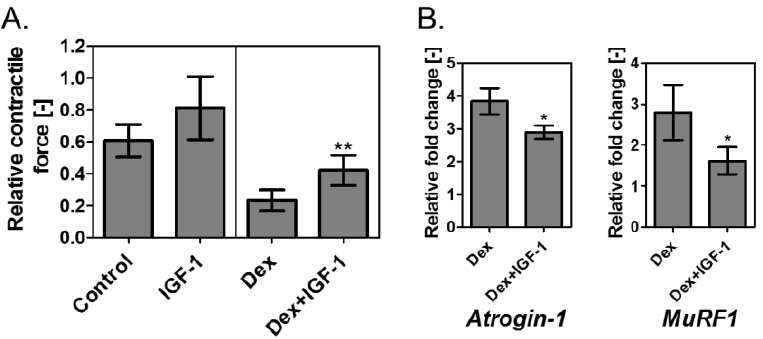
Figure 5. Effects of IGF-I addition on atrophic skeletal muscles. ( A ) Variation in contractile force of atrophic tissues by the addition of Dex. The muscle tissues on the device prepared by six-day differentiation culture (0 h) were treated with 100 µM Dex for 48 h (Dex group). For Dex + IGF-I group, 8 ng/mL IGF-I was added at 24 h and incubated for the subsequent 24 h. Muscle contractile force was measured at 48 h. The relative value was determined with the contractile force at 0 h designated as 1. For the control and IGF-I groups, similar volume of ethanol was used instead of Dex. Results represent mean ± SD ( n = 6). ** p < 0.01 versus Dex; ( B ) Atrogin-1 and MuRF-1 gene expression levels in muscle tissues treated with 100 µM Dex for 24 h, and 100 µM Dex and 8 ng/mL IGF-I for subsequent 24 h are expressed relative to β-actin . Results represent mean ± SD ( n = 3). * p < 0.05 versus Dex.